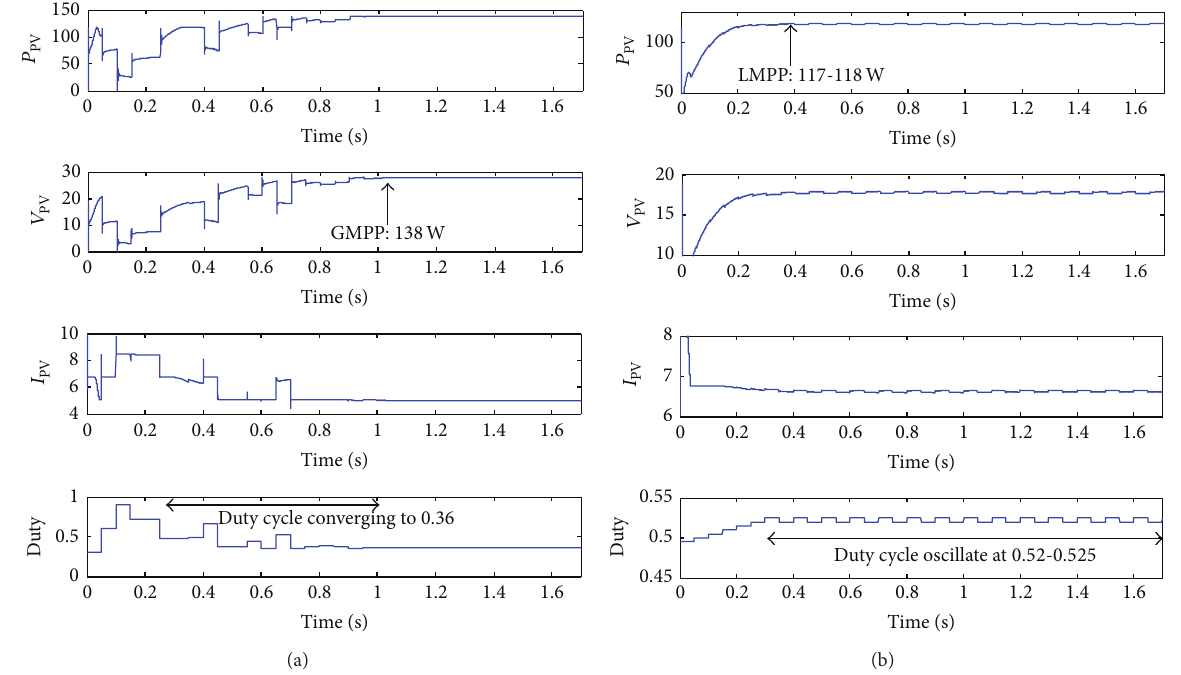
Figure 7: Simulation results for PV array under partial shading of 1.0kW/m 2 , 0.8 kW/m 2 , 0.2 kW/m 2 , and 0.6 kW/m 2 ; (a) proposed DE algorithm and (b) P&O